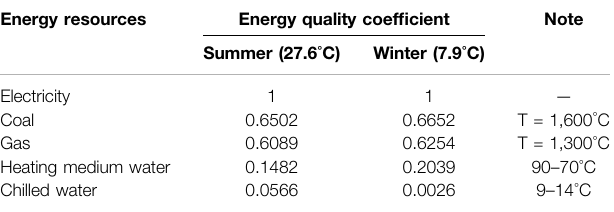
TABLE 2 | The energy quality coef fi cient of common energy